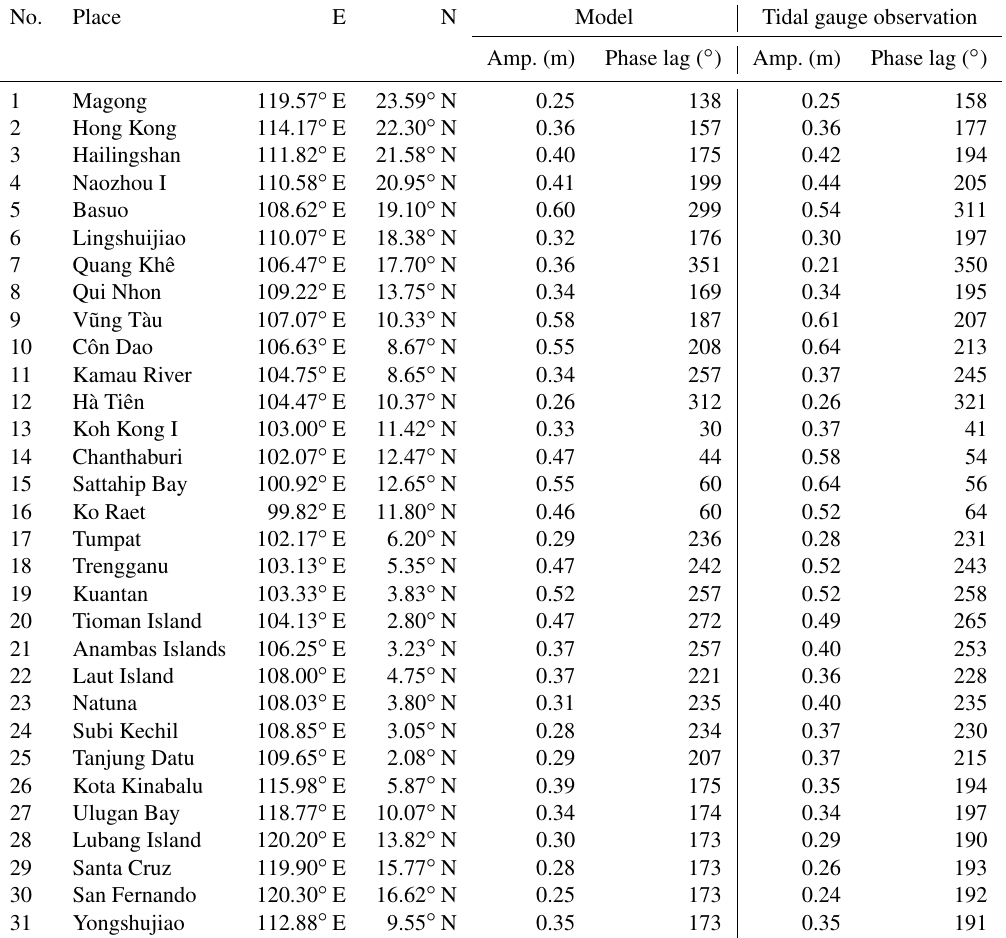
Table 1. Comparison between model-produced and observed K 1 tidal amplitudes (m) and phase lags (degrees refer to Greenwich time).